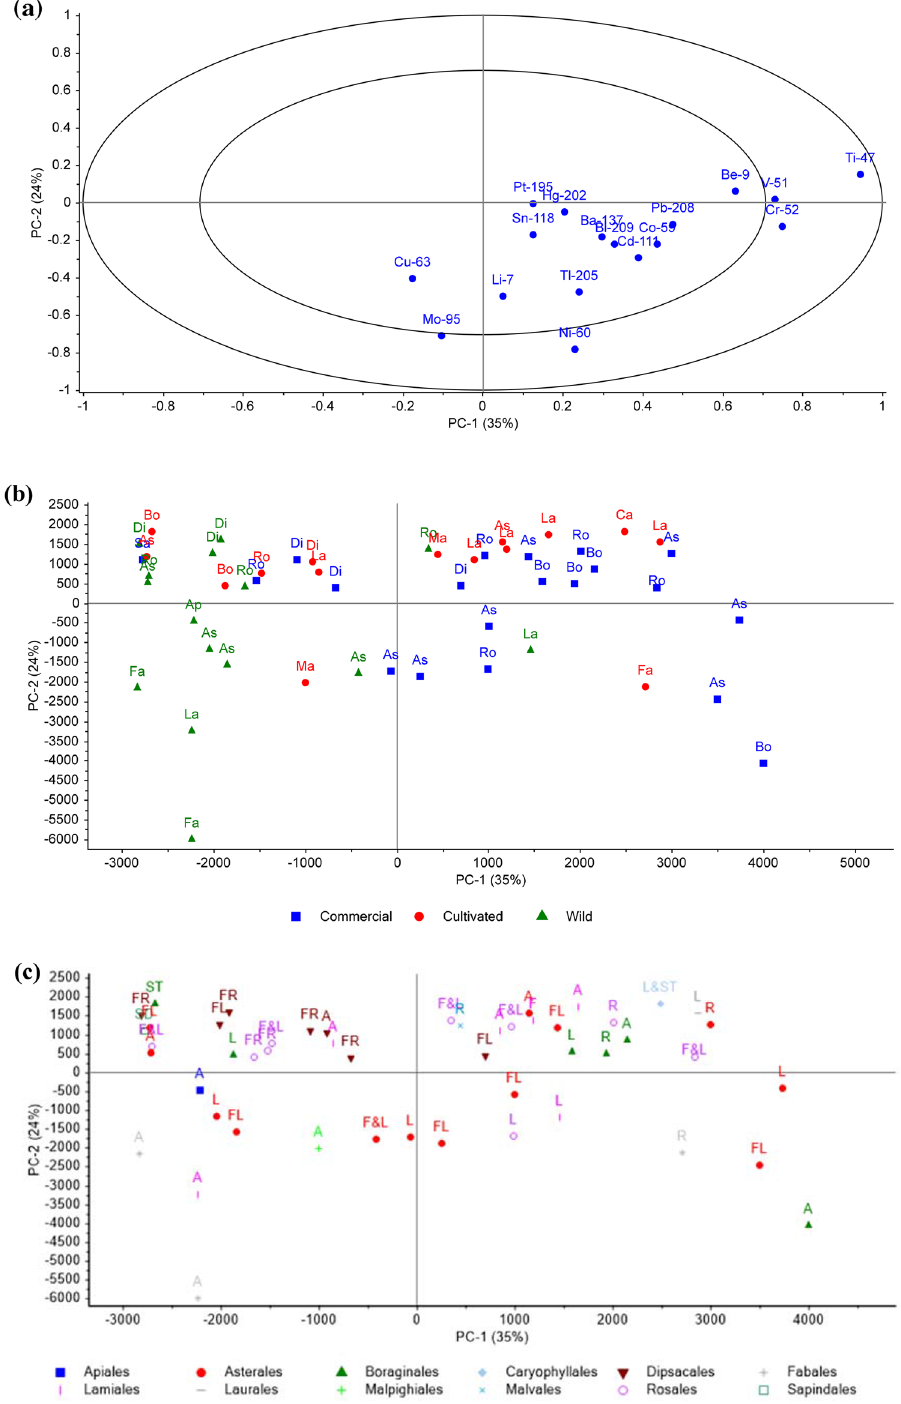
Figure 2. PCA (PC1vPC2) correlation loadings ( a ) and score plots grouped by ( b ) type and labelled by taxonomic order, and ( c ) grouped by taxonomic order and labelled by plant part. Taxonomic orders (e.g. Ro = Rosales) and plant part (e.g. F&L = Flower and Leaf; R = Root; L&ST = Leaf and Stem) abbreviated as per Table